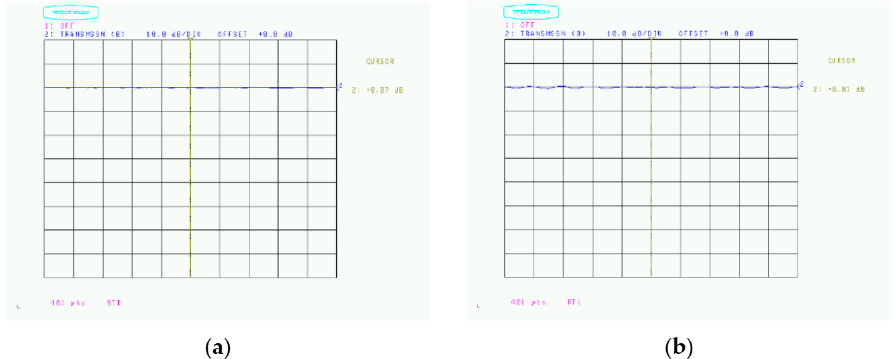
Figure 15. Changes in the amount of radio wave absorption depending on the board: ( a ) Calibration